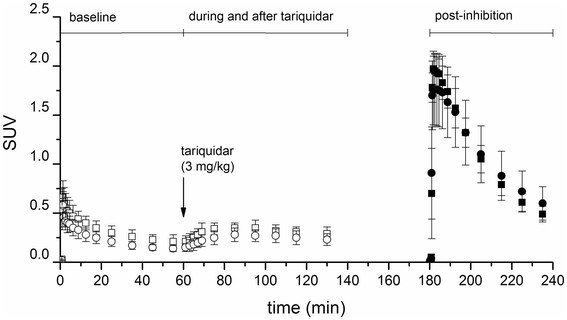
WB (R)-[11C]verapamil time-activity curves in rats. Average ± standard deviation (R)-[11C]verapamil concentration-time curves in rat WB expressed as SUV for naïve (squares) and 48-h post SE (circles) animals at baseline (open symbols) and at post-inhibition (full symbols). Tariquidar (3 mg/kg) was administered 60 min after the start of the baseline scan as an I.V. bolus over 60 sec (arrow).